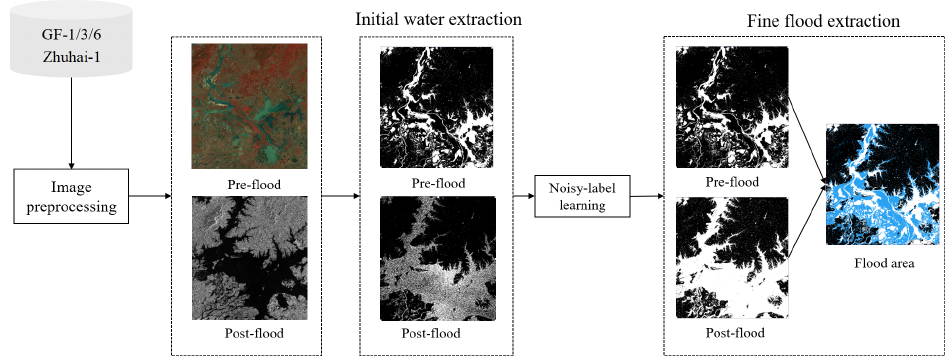
Figure 2. The main flowchart of flood